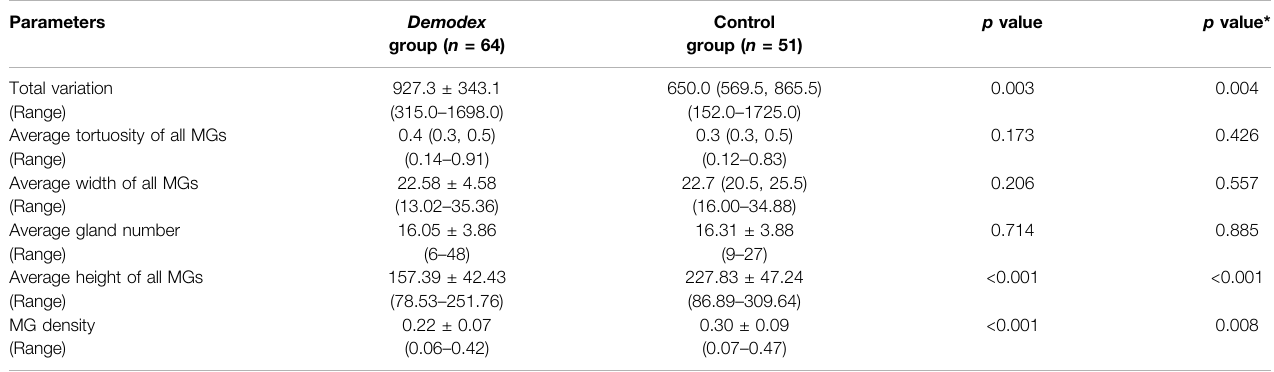
TABLE 2 | Upper lid MG morphological changes in Demodex -positive and Demodex -negative patients.